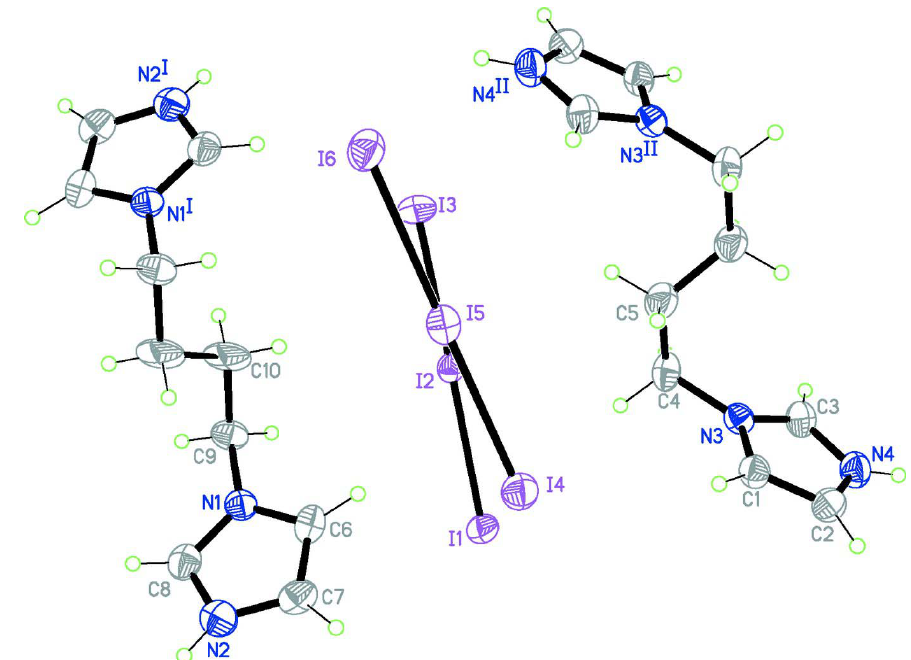
Figure 1 The molecular structure of (I), showing displacement ellipsoids at the 30% probability level for non-H atoms.